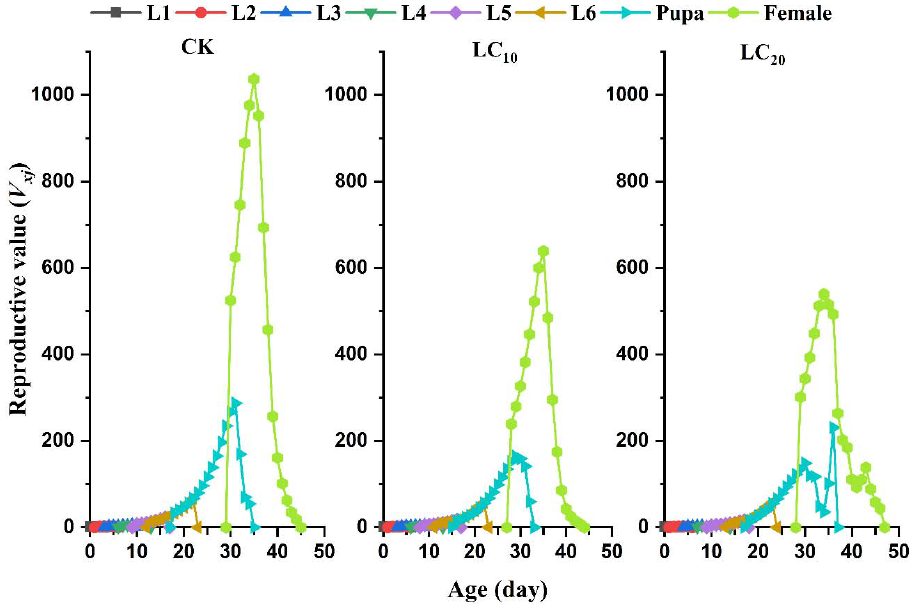
Figure 4. Age-stage specific reproductive value ( V xj ) of the immature and adult FAW offspring generation from the FAW parental generation exposed to sublethal concentrations (LC 10 and LC 20 ).